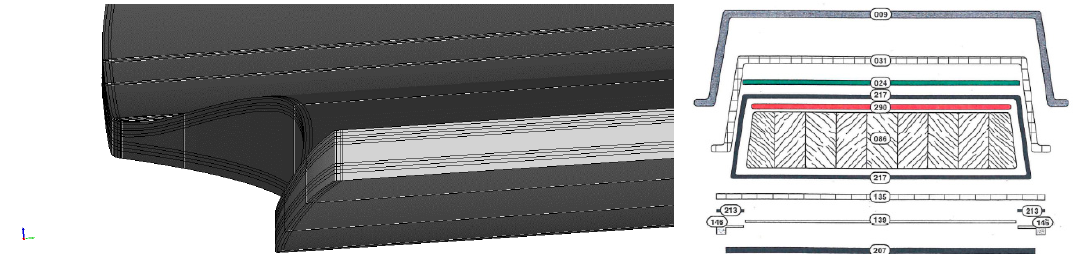
Figure 6. Di ff erent layers of the solid model. Figure 6. Different layers of the solid model. Figure 6. Different layers of the solid model. Figure 6. Different layers of the solid model.